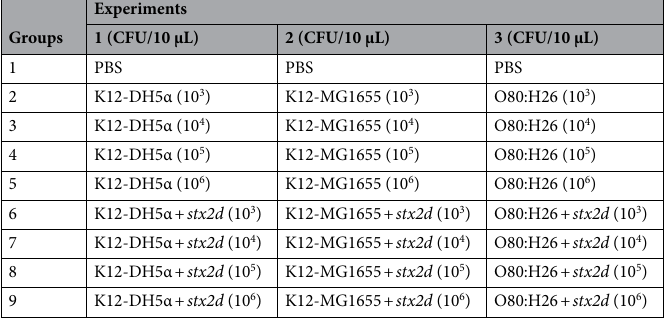
Table 3. Summary table of the G. mellonella larvae groups inoculated in triplicate for the main experiments (survival and titration).